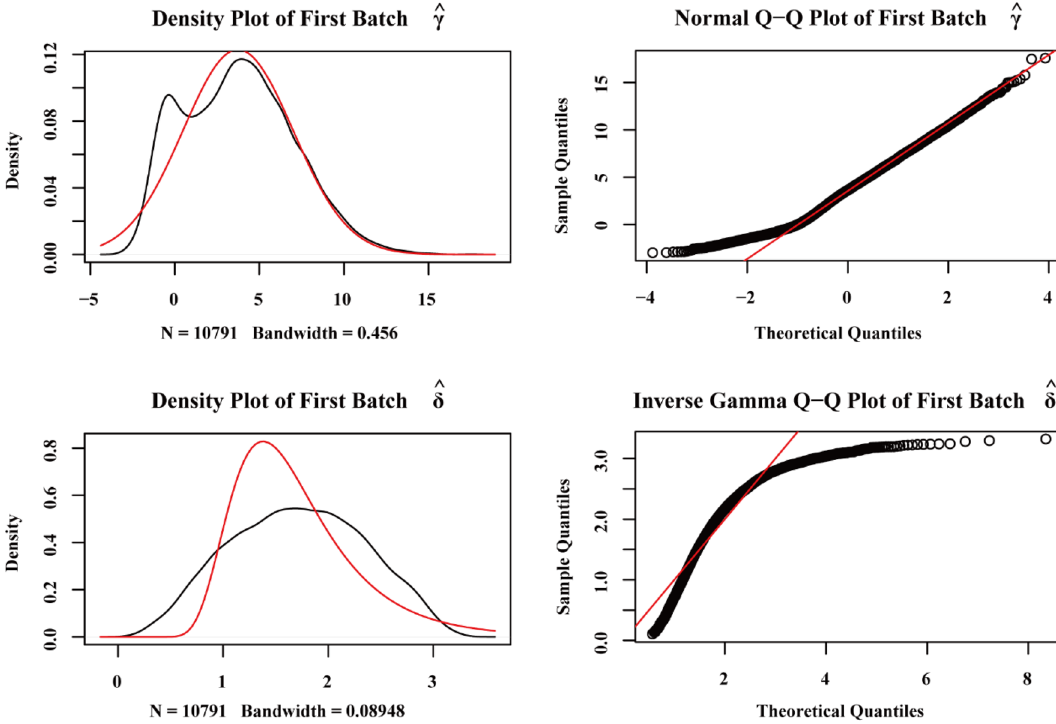
Figure 1. Q-Q chart of data set eliminating inter-batch